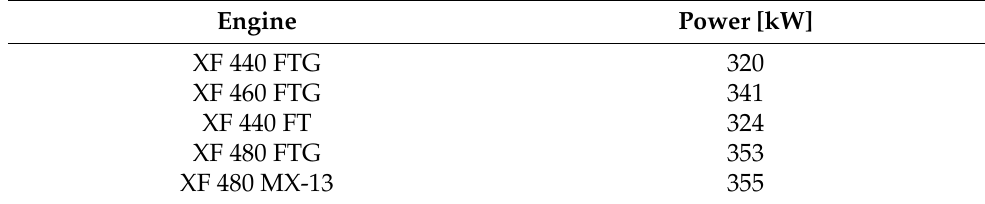
Table 1. Details of all the vehicles included in the study. They were DAF trucks with similar characteristics. The rated power was between 320 and 355